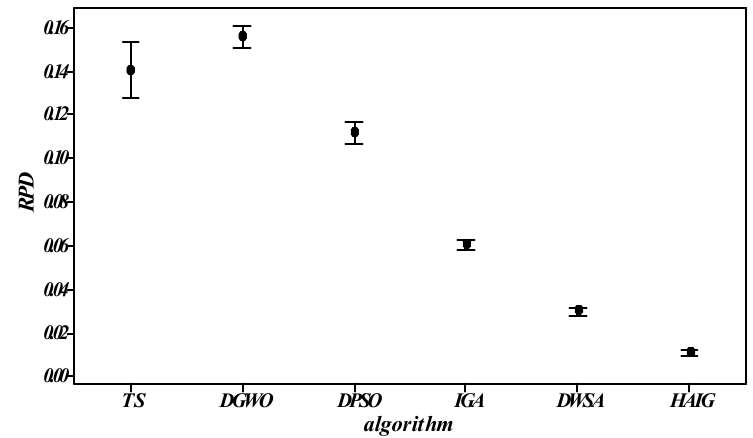
Figure 8. Comparisons of the algorithms.